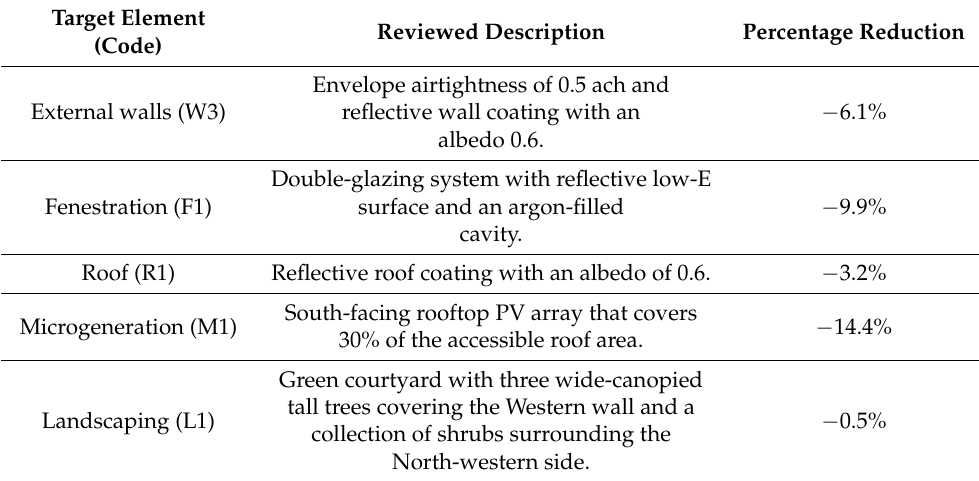
Table 16. The selected top performing single retrofit strategies.